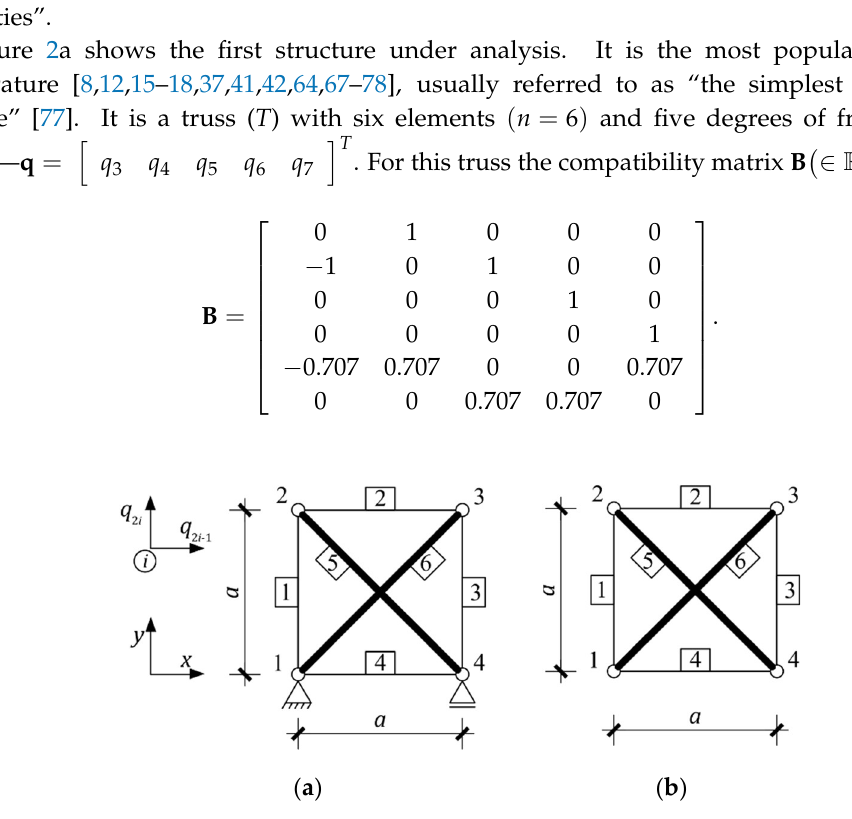
Figure 2. The “X” truss: ( a ) supported, ( b ) unsupported.